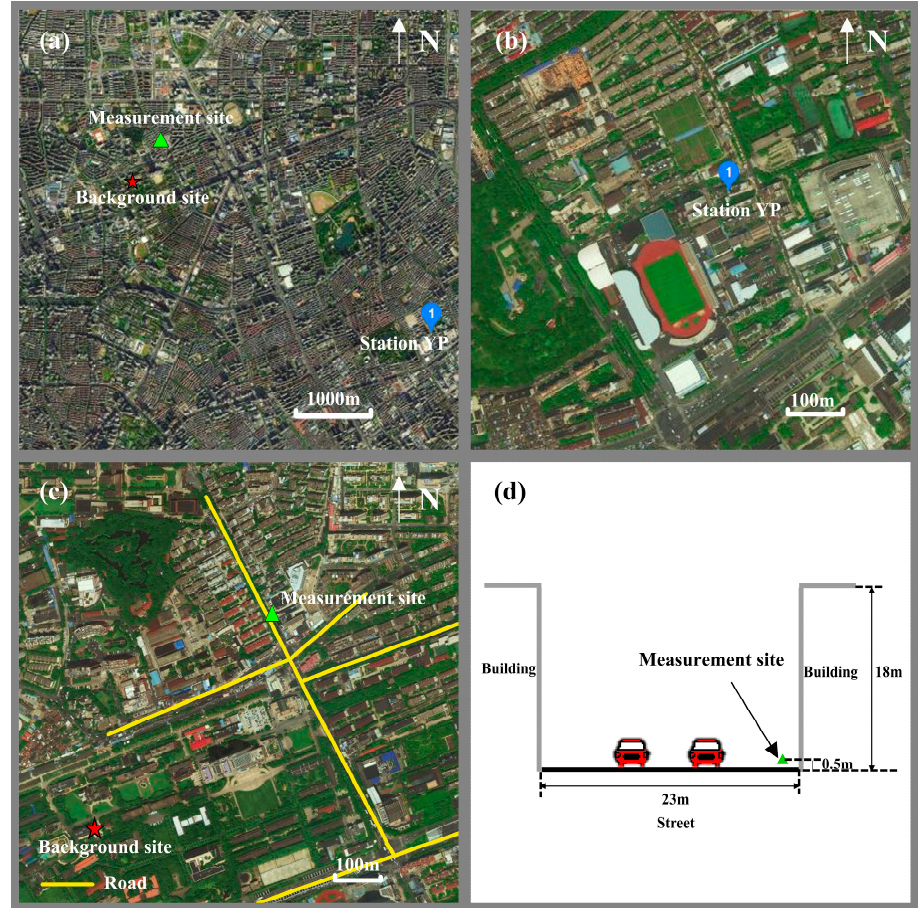
Figure 1. Measurement and background sites. ( a ) Locations of measurement site, background site and Station YP; ( b ) Surroundings of Station YP; ( c ) Surroundings of measurement site and background site; ( d ) Measurement site in the street